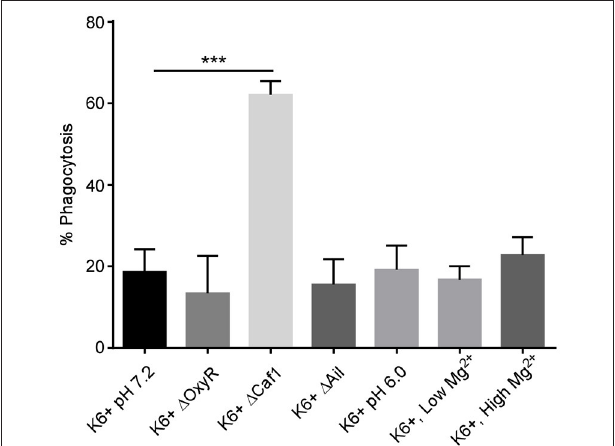
FIGURE 1 | Deletion of the caf1 gene increases phagocytosis of Y. pestis by neutrophils. Human peripheral blood neutrophils were infected in vitro with Y. pestis KIM6 + or the deletion mutants. Additionally, neutrophils were infected with Y. pestis grown at pH6.0 or with low Mg 2 + to pre-induce PhoPQ expression prior to infection. At 45min post-infection, gentamicin was added to half the wells to kill extracellular bacteria. At 60min post-infection all wells were harvested, cells washed, lysed, triturated and plated to quantify CFU. The % phagocytosis was calculated by dividing the number of intracellular CFU from the gentamicin treated wells by the total CFU in the non-treated wells and multiplying by 100. The mean of 3 independent experiments with cells from 3 different donors is shown for each condition. Error bars represent SEM. Statistical differences between KIM6 + pH7.2 and the other conditions were calculated by one-way ANOVA followed by Dunnett’s multiple comparison test. *** p -value of < 0.001.